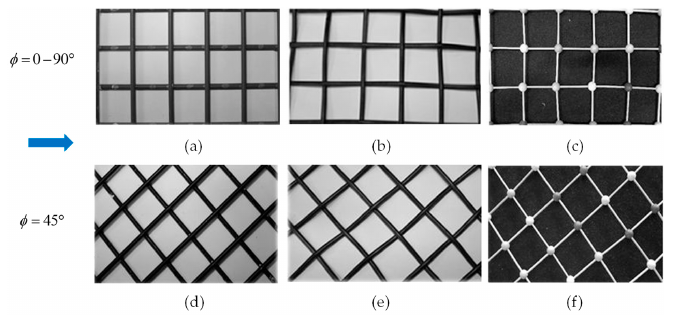
Figure 2. Photographs of the actual spacers tested, with their filaments oriented at 0–90° (top row) or at 45° (bottom row) with respect to the flow direction (arrow). ( a , d ) overlapped; ( b , e ) woven; ( c , f ) spheres. The pitch-to-height ratio P / H = 4 in all of the cases.